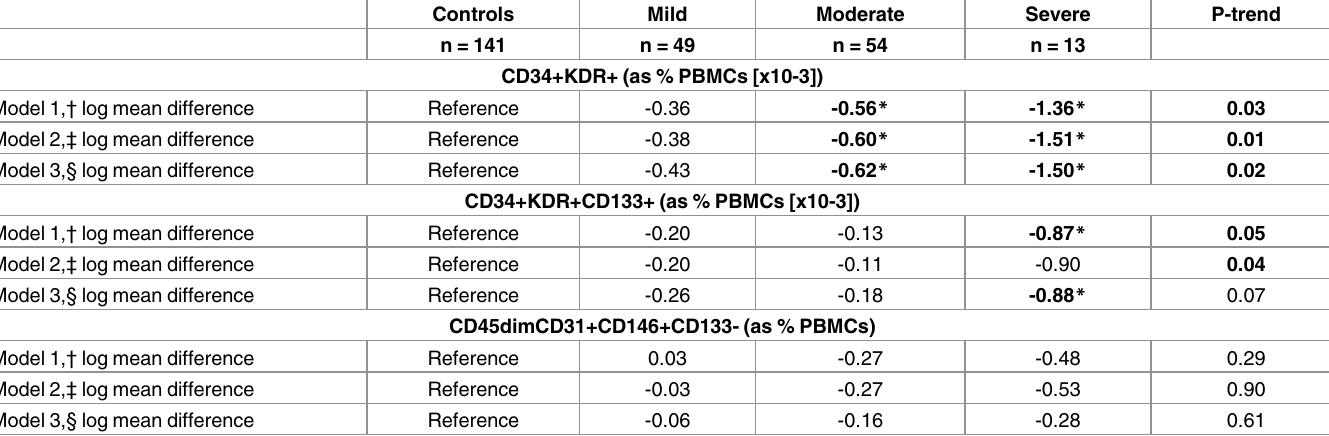
Table 2. Mean difference in endothelial progenitor cells and circulating endothelial cells by COPD